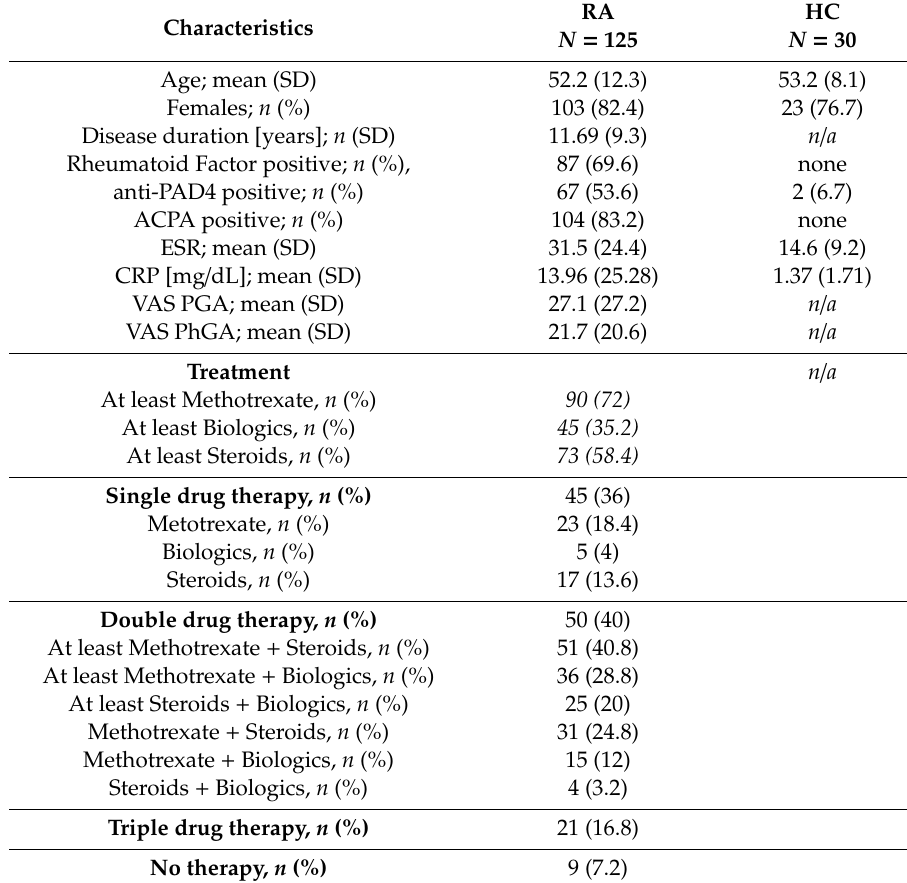
Table 1. The characteristic of the rheumatoid arthritis (RA) group, medications and healthy control (HC) group. Anti-PAD4, antibodies against Peptydyl Arginine Deiminase type 4; ACPA, anti-citrullinated protein antibodies; VAS PGA, Visual Analogue Scale Patient Global Assessment; VAS PhGA, Visual Analogue Scale Physician Global